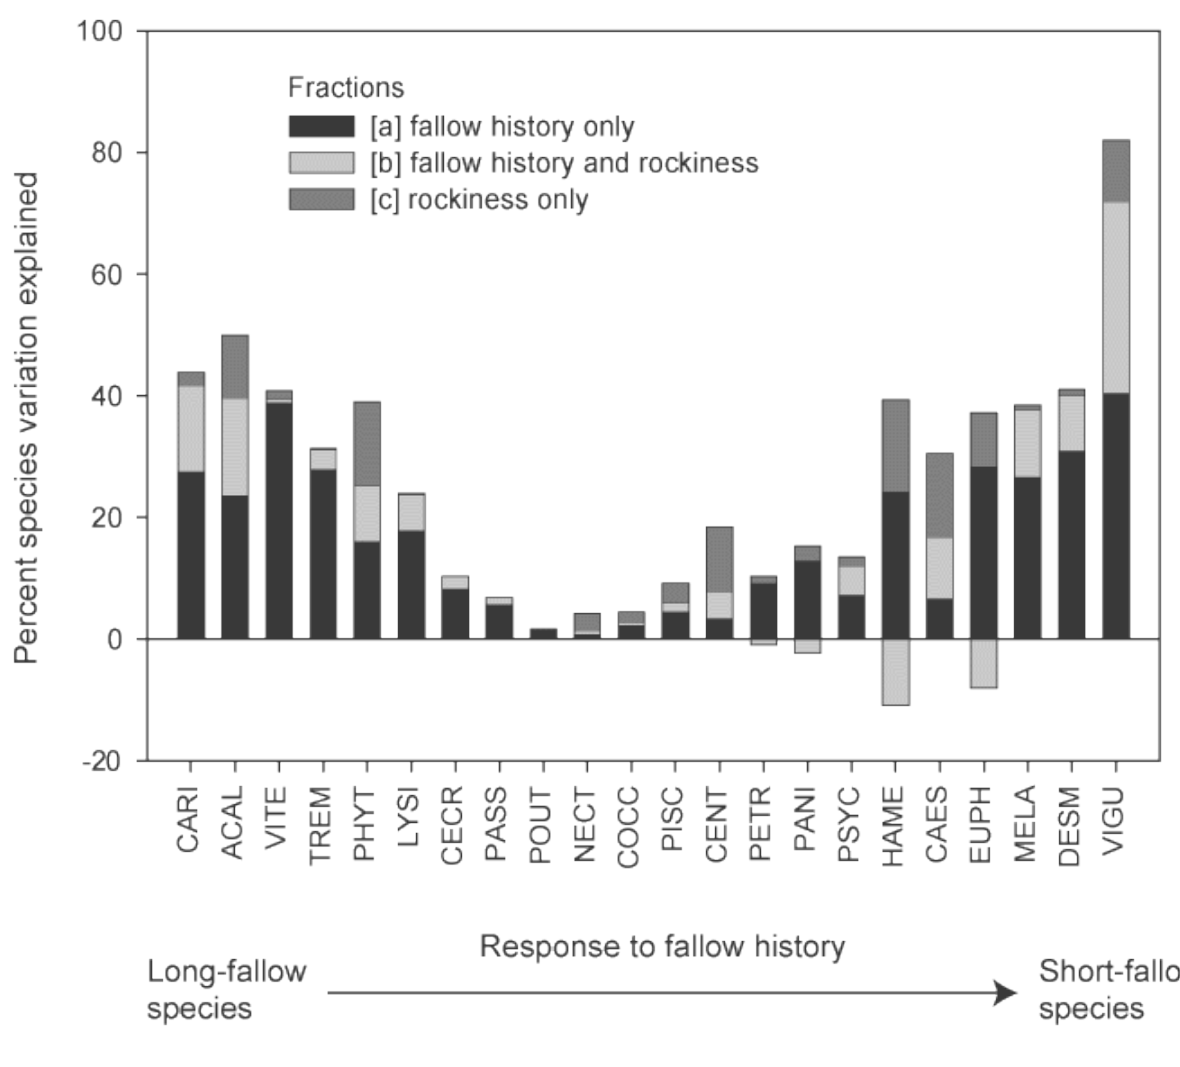
Fig. 7. Percentage of species variation explained by three fractions, after controlling for forest type: [a] fallow history only, [b] joint effect of fallow history and rockiness, and [c] and rockiness only. Species are arranged according to their response to the first two fractions. Negative values for the joint fallow- rockiness fraction occur in some cases because this fraction is calculated by subtraction rather than directly estimated. In these cases, the species variation is better explained by rockiness and fallow history together than by the sum of their independent effects (Legendre and Legendre 1998:532-533). Species' codes as in Tables 1 and